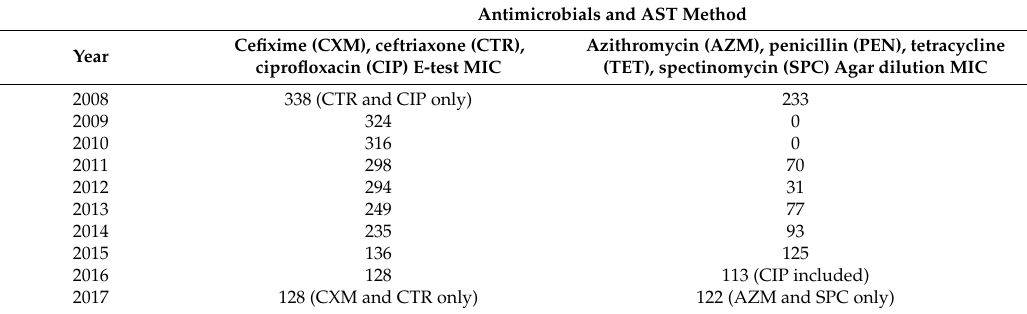
Table 2. Number of Neisseria gonorrhoeae isolates tested for susceptibility to various antimicrobials by calendar year, Johannesburg,